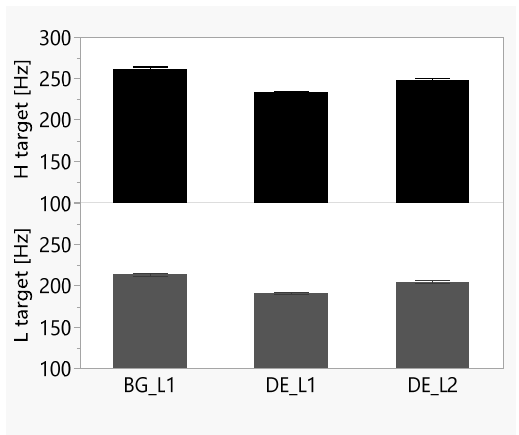
Figure 7. Mean pitch height (in Hz) of the L target ( lower panel ) and H target ( upper panel ) for the three data sets. Error bars represent standard errors.